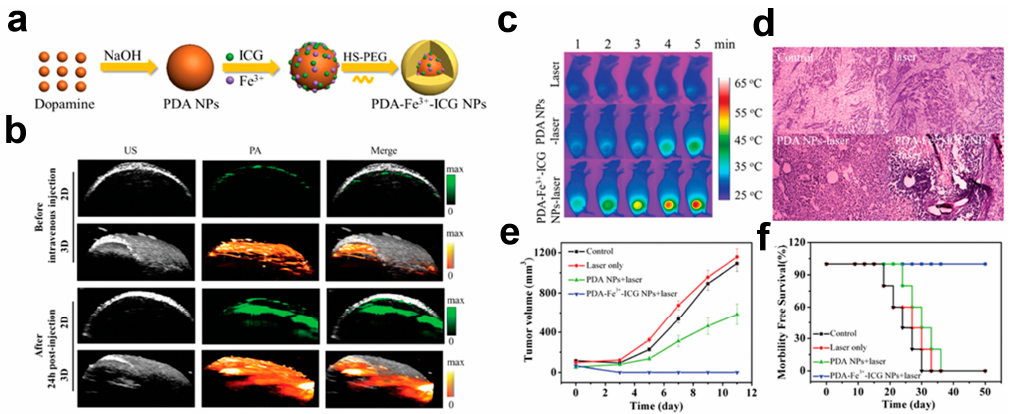
Figure 5. ( a ) Schematic illustration of the preparation process of polydopamine nanoparticles (PDA- NPs) loaded with indocyanine green (ICG) and labeled with Fe 3+ ; ( b ) in vivo OA images of the PDA– Fe 3+ –ICG NPs in a 4T1-bearing tumor mice model; in Vivo photothermal therapy (PTT) in 4T1-bearing tumor mice showing ( c ) IR thermal images of 4T1 tumor-bearing mice exposed to 808 nm laser for 5 min (1.0 W·cm − 2 ); ( d ) H&E stained images of tumor sections collected from the different treated groups of mice 6 h post-treatment; ( e ) tumor growth curves for the different groups of 4T1 tumor- bearing mice; ( f ) survival rates of the mice bearing 4T1 tumors after the different treatments. The data indicate the mean and standard errors ( n = 5). Reprinted with permission from reference [36], Copyright 2016, Royal Society of Chemistry.